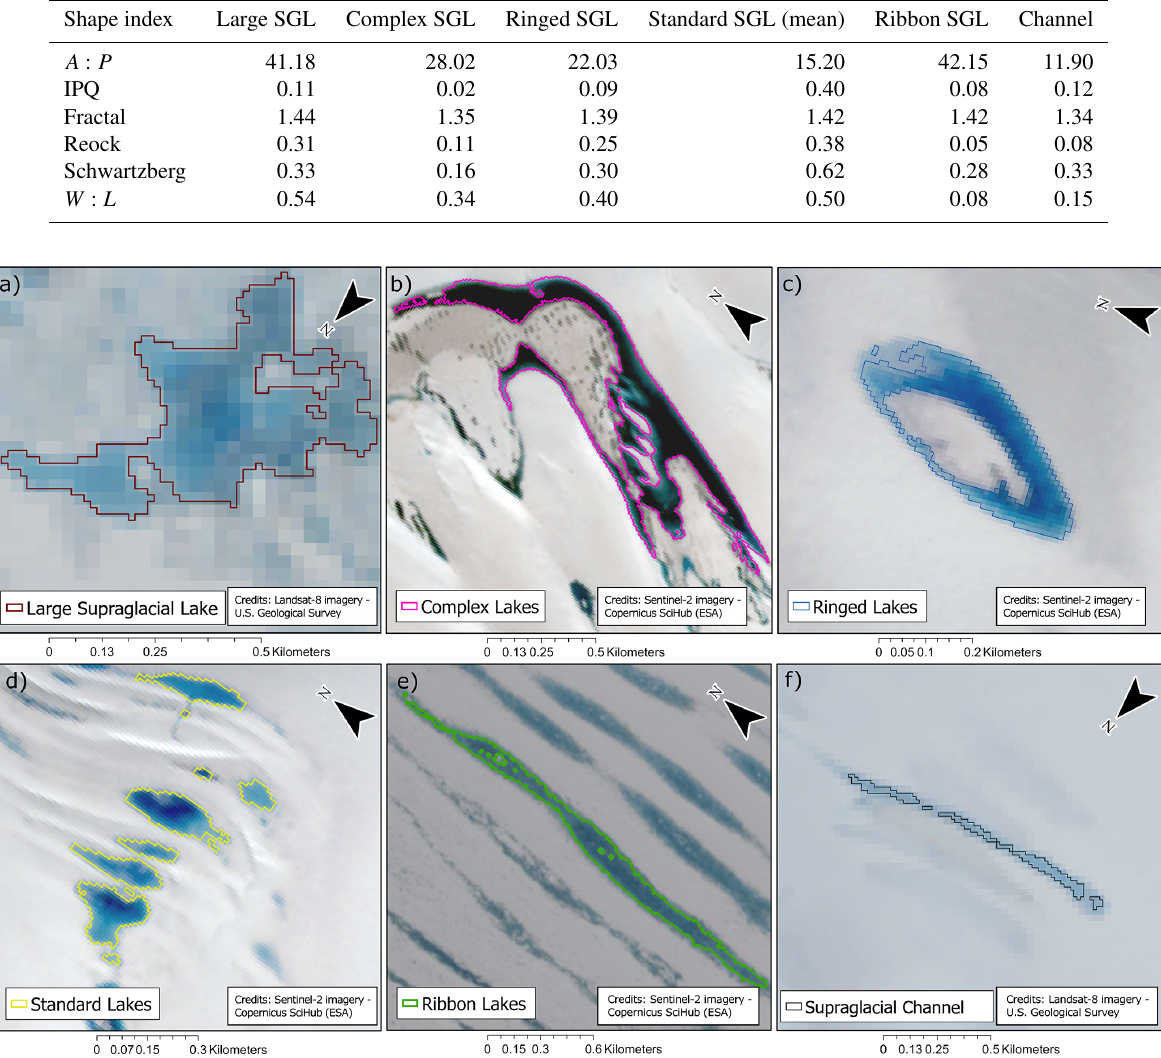
Table 2. Value of each individual shape index (Eqs. 9–14) for the feature type defined in Fig. 10.